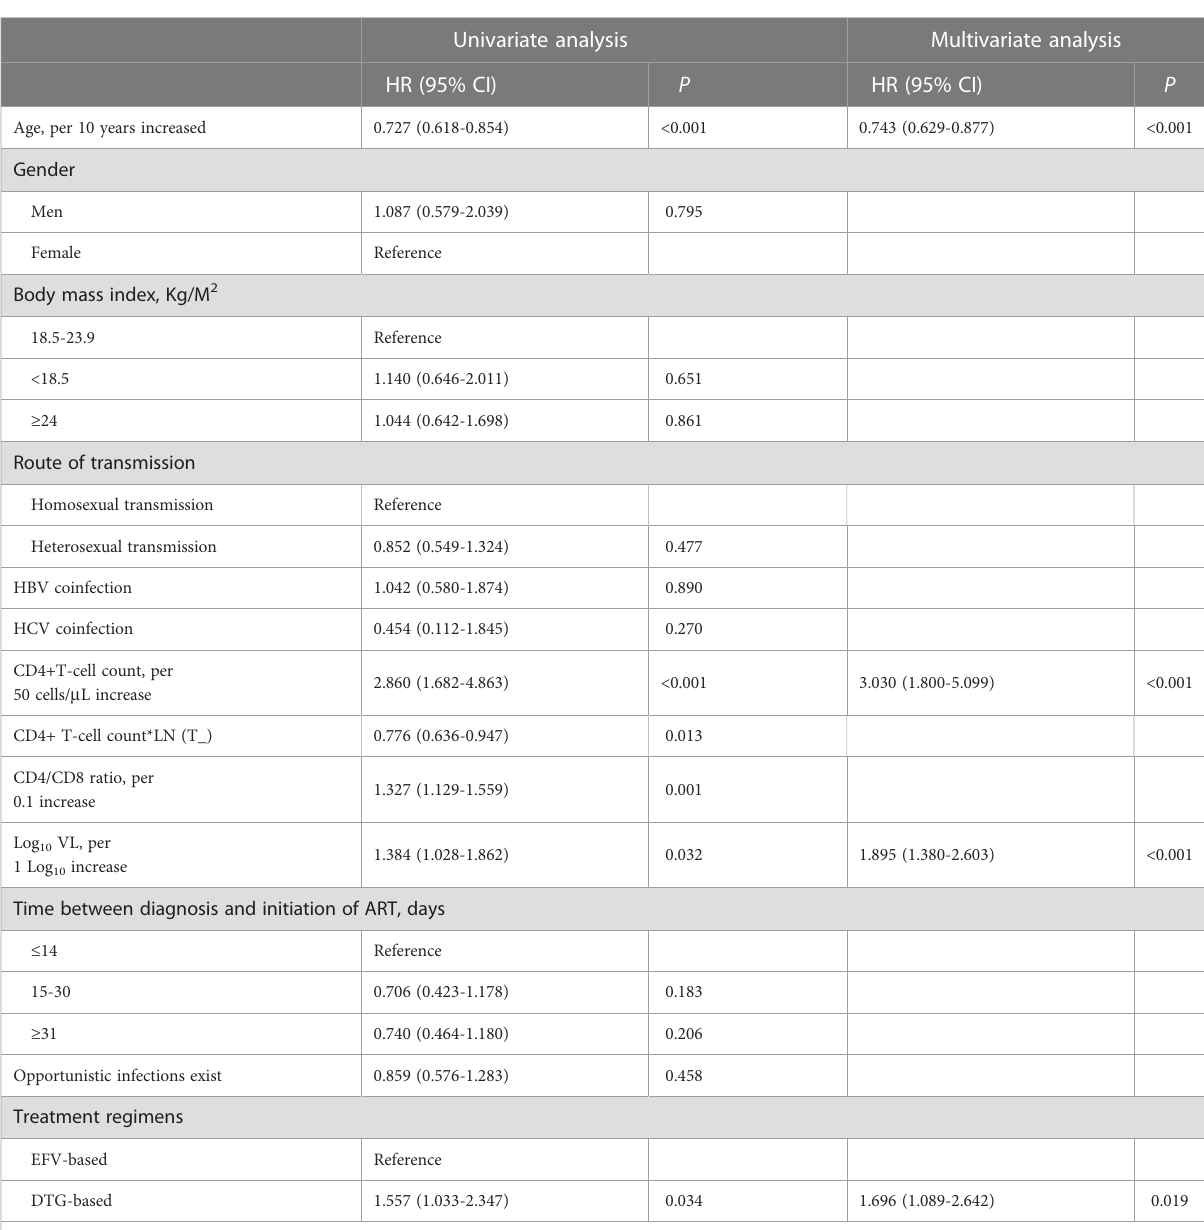
TABLE 3 Cox regression analyses for immune recovery.